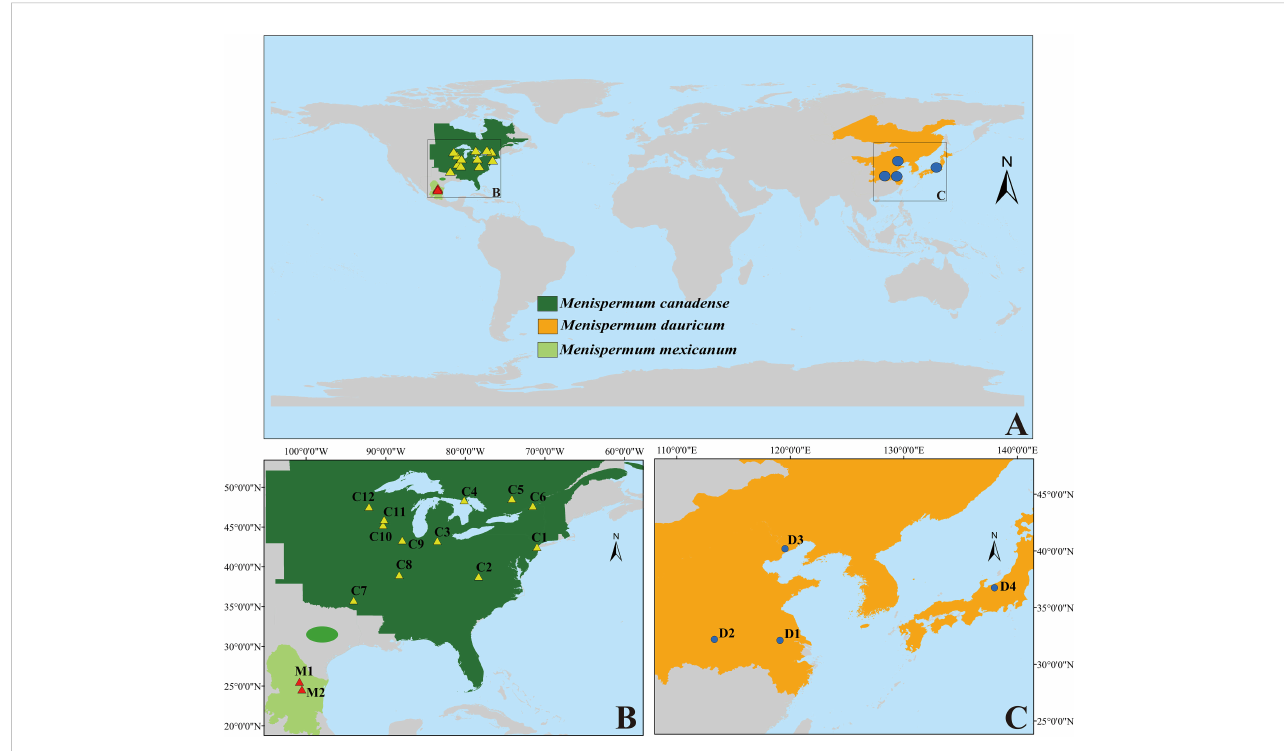
FIGURE 1 The distribution/sampling sites of M. canadense (dark green/yellow triangle), M. dauricum (orange/blue dot), and M. mexicanum (light green/red triangle). (A) world map; (B) eastern North America; (C) East Asia. Sample codes are the same as in Table